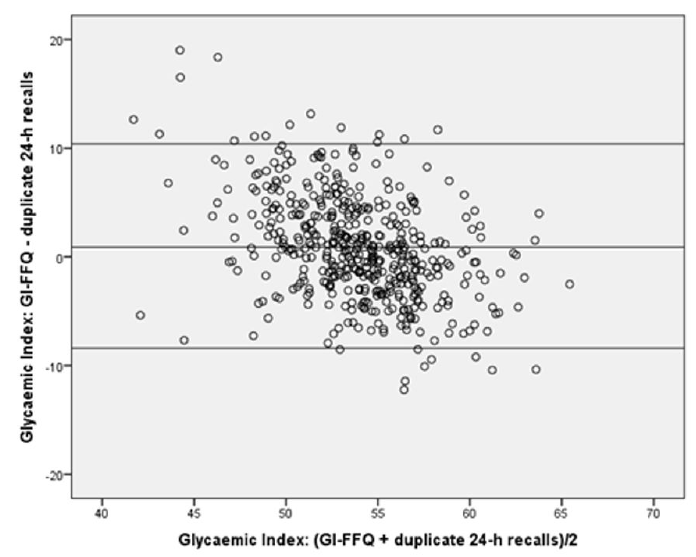
Figure 3. Bland-Altman plot for glycaemic index showing the relative validity of the GI-FFQ versus the duplicate 24 h-recall. Middle line indicates the mean; upper and lower lines indicate borders based